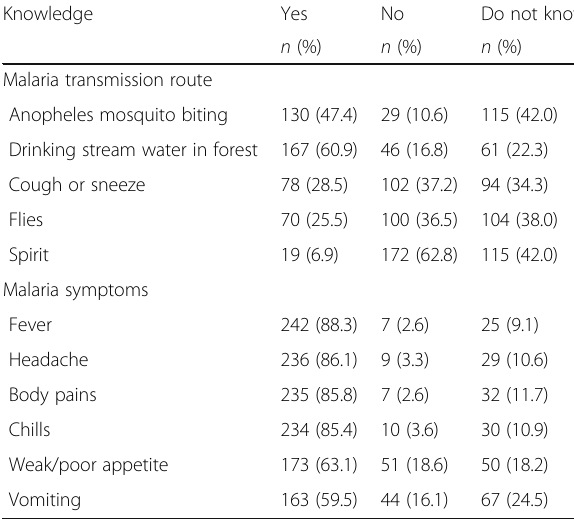
Table 3 Knowledge on transmission routes and symptoms